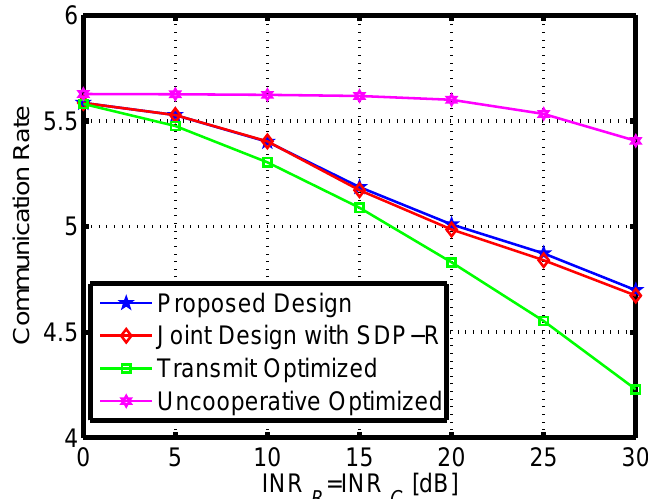
Figure 7. The communication rate under different INR R = INR C of mutual interference.